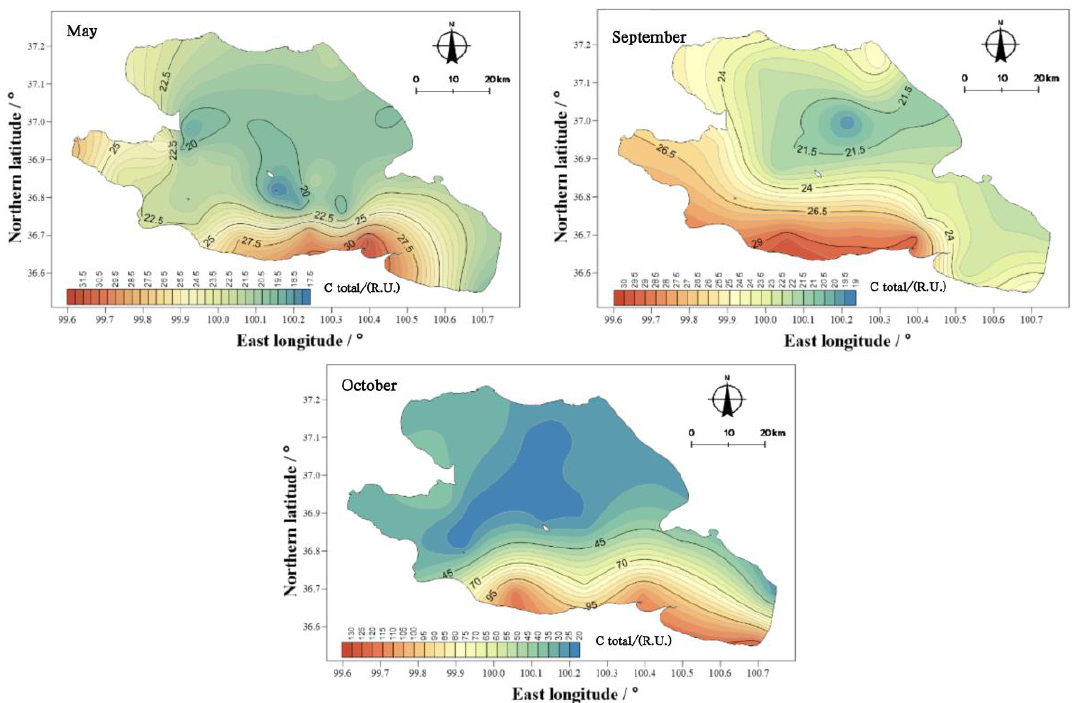
Figure 14. Spatial distribution of the total fluorescence intensity of FDOM in Qinghai Lake in different seasons.